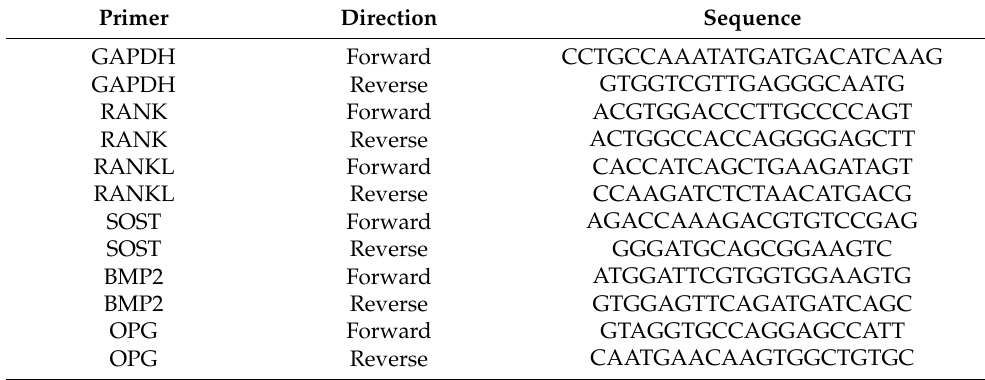
Table 1. PCR primers used in this